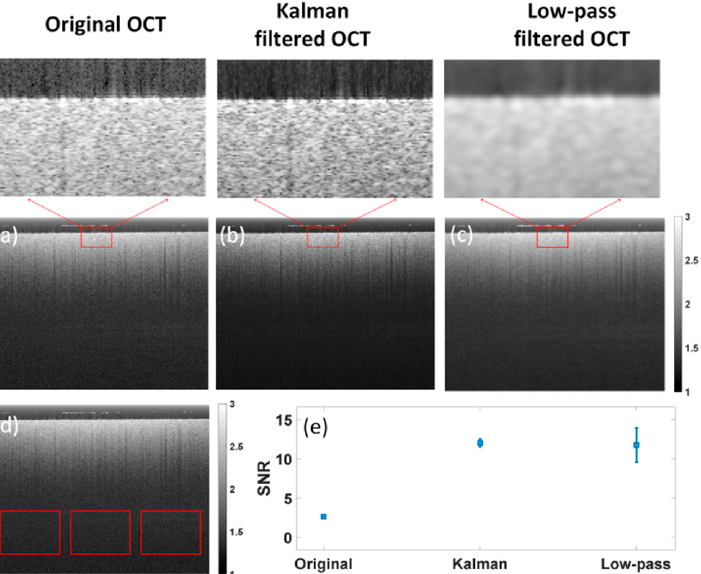
Figure 5. Comparison between using Kalman filter and using low-pass filter in phantom experiments. ( a – c ) The original OCT images, the Kalman-filtered OCT images and the low-pass-filtered OCT images, respectively. The upper subimages are locally magnified images from ( a – c ), respectively. Three regions extracted from the deep positions of ( a – c ) are shown in ( d ). ( e ) The mean and standard deviation of the SNR of the three regions.